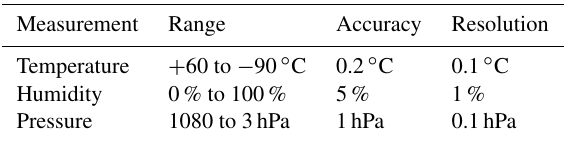
Table 1. RS92-SGP specifications according to the